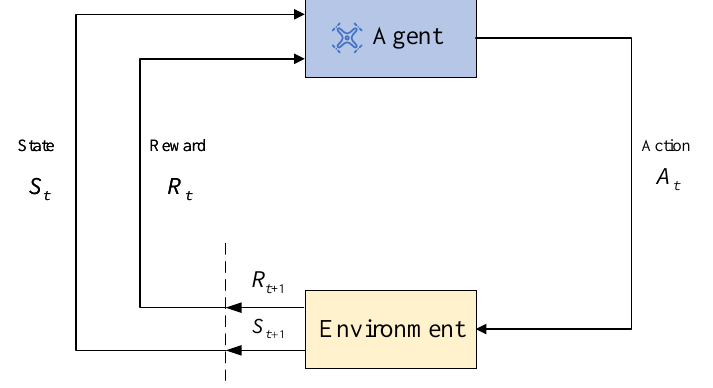
Figure 3. Learning process of